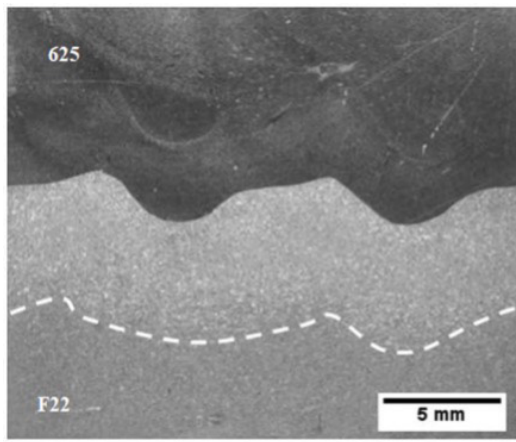
Figure 8. Buttering weld interface as-welded.